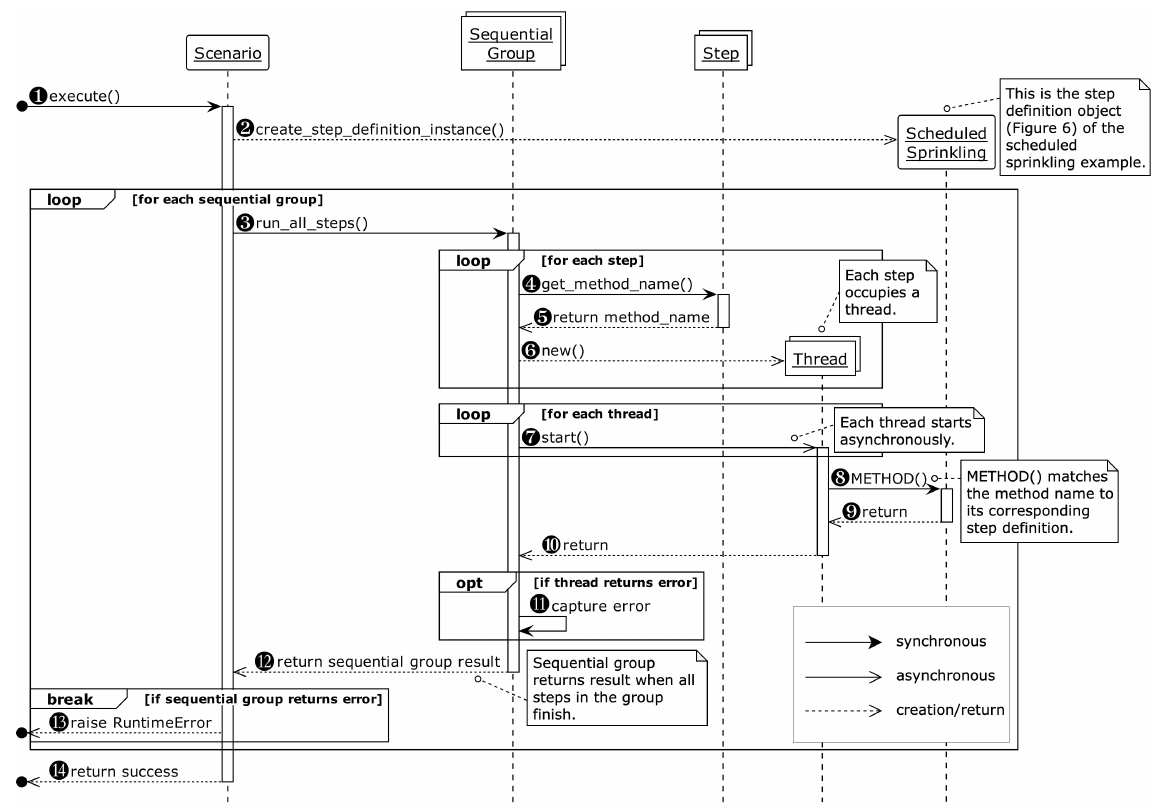
Figure 7. Sequence diagram of calling the execute method of the scheduled sprinkling scenario in concurrentSpec .